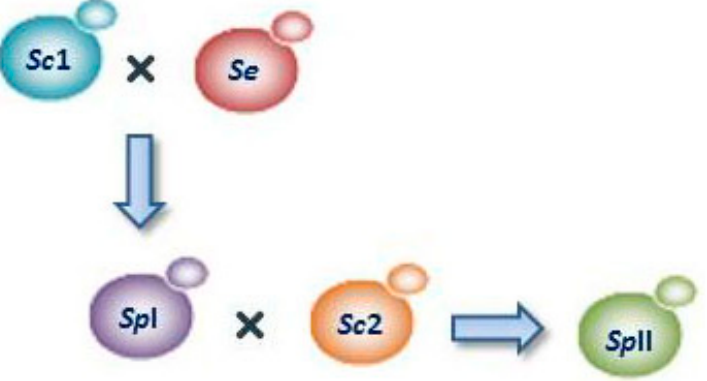
Figure 1. Origin of lager yeasts Saccharomyces pastorianus group I ( Sp I) and II ( Sp II). Sp I was produced by hybridization of S. cerevisiae ( Sc 1) with S. eubayanus ( Se ), and Sp II was obtained by a further hybridization between Sp I and a different S. cerevisiae strain ( Sc 2).